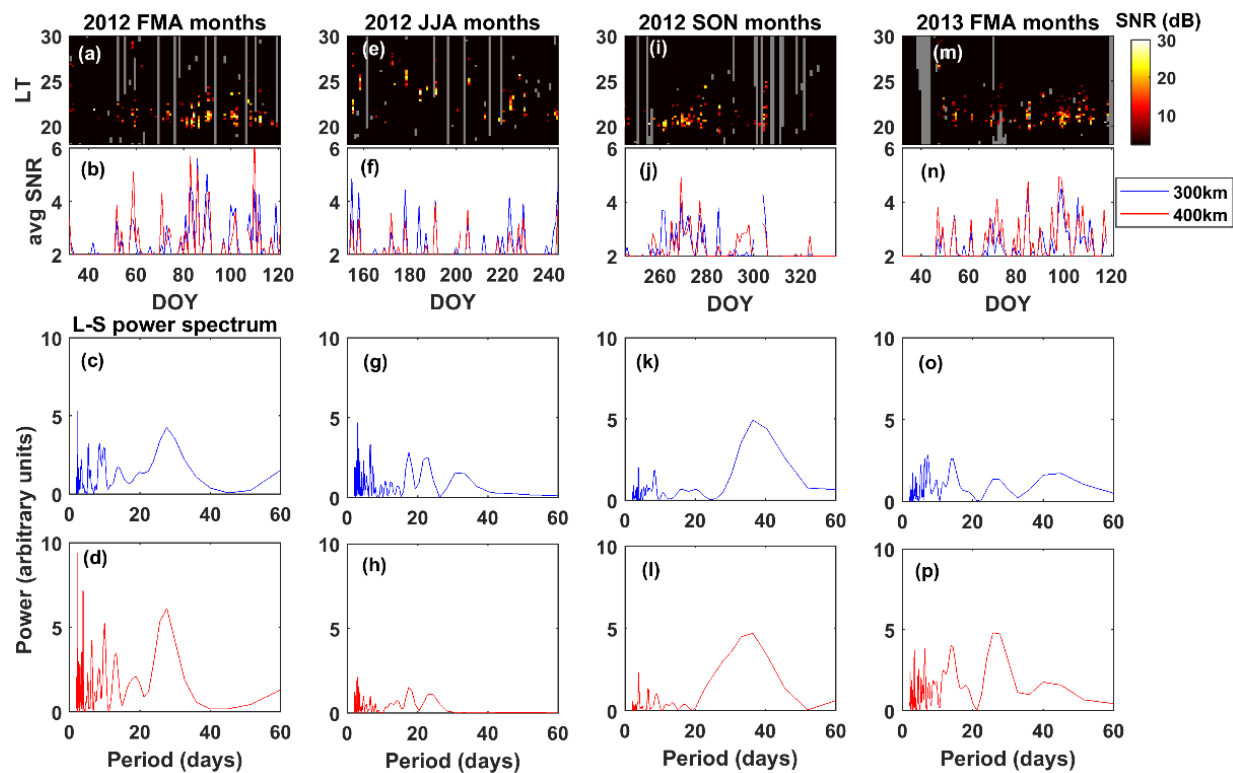
Figure 4. Intra-seasonal variation in nocturnal SNR in equinoctial and summer months. ( a ) Nocturnal variation in SNR at 300 km in vernal equinox months (Febuary, March, and April) in 2012. ( b ) The day-of-year series of nocturnal average SNR in vernal equinox months at 300 km and 400 km is indicated in blue and red, respectively. ( c , d ) The Lomb–Scargle spectra of SNR variation at 300 km and 400 km, respectively, are presented and derived using the DOY series shown in ( b ). ( e – h ) present the same as ( a – d ), but for the summer months (June, July, and August) in 2012. ( i – l ) present the same as ( a – d ), but for the autumnal equinox months (September, October, and November) in 2012. ( m – p ) present the same as ( a – d ), but for the vernal equinox months in 2013.